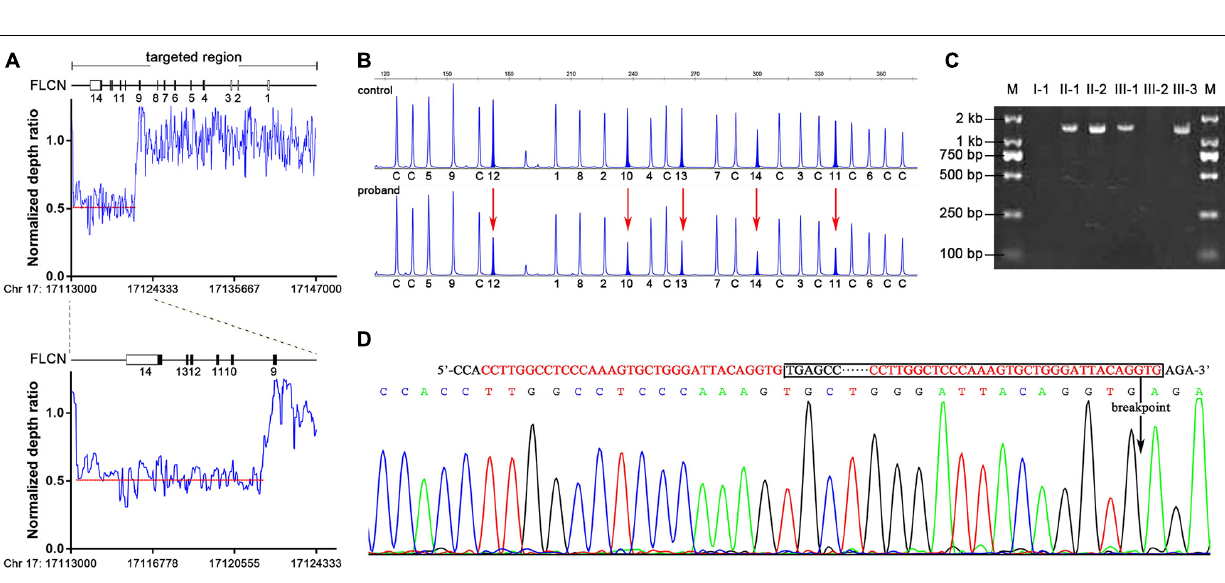
8,384 bp deletion encompassing exons 10–14 (chr17: